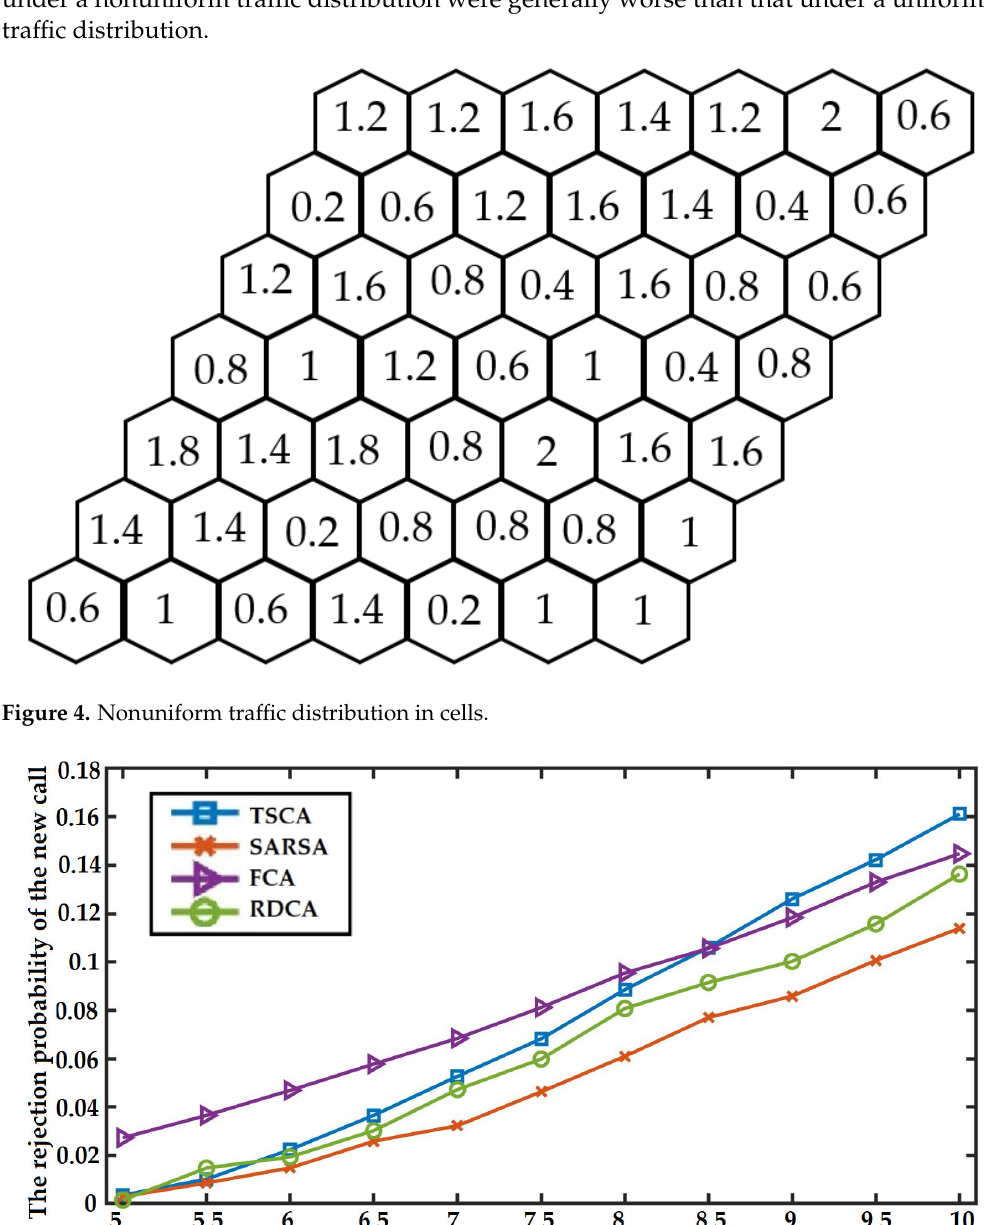
Figure 3. Performance comparison under uniform traffic distributions. ( a ) The rejection probability of the new call; ( b ) the rejection probability of the handoff call; ( c ) the rejection probability of the total call.